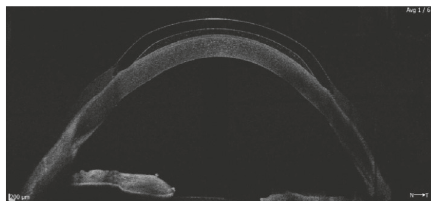
Figure 1: Optical coherence tomography with Revo (Optopol Technologies; Zawiercie, Poland) was performed during hybrid contact lens fitting. Fitting was performed to ensure the central vault of the rigid part provided adequate clearance over the